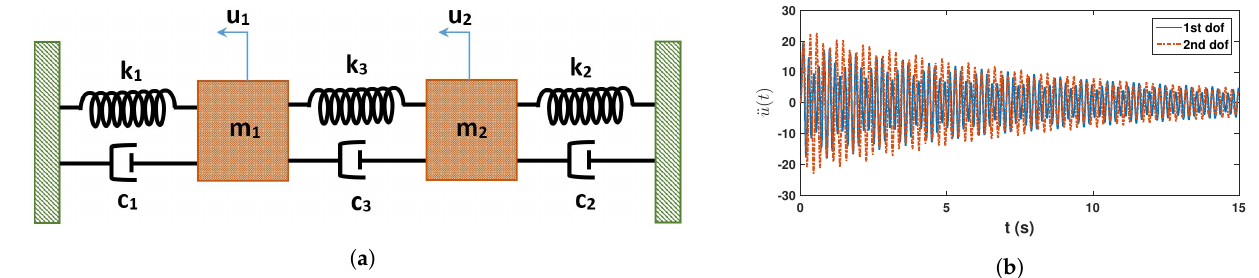
Figure 2. 2 dof system; ( a ) structural details & ( b ) sample acceleration